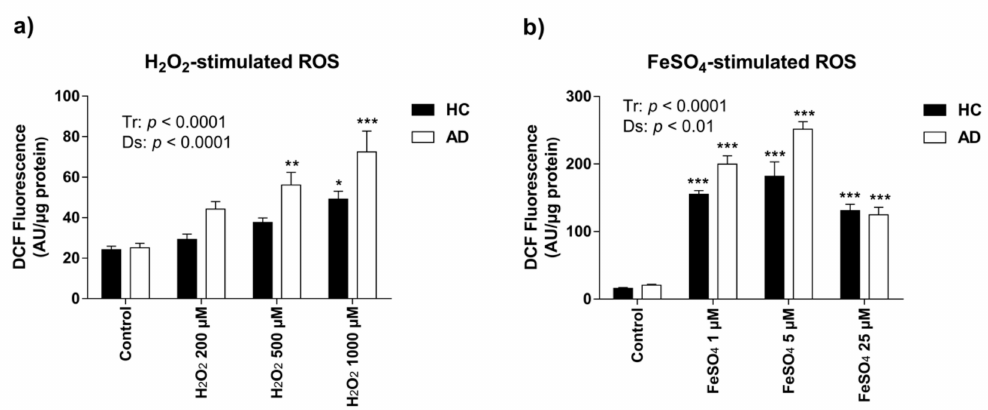
Figure 1. Reactive oxygen species (ROS) generation by lymphoblast cell lines in response to acute exposure (1 h) to oxidizing agents measured by 2 (cid:48) 7 (cid:48) -dichloro-dihydro-fluorescein diacetate (DCFH-DA) assay. ( a ) H 2 O 2 –stimulated ROS. One h of treatment with H 2 O 2 induced oxidative stress, showing significant greater ROS generation in Alzheimer’s disease (AD) than in healthy control (HC) lymphoblasts. Two-way ANOVA indicated an e ff ect of both treatment (Tr) (F(3,16) = 19.52; p < 0.0001) and disease (Ds) (F(1,16) = 17.21; p < 0.001); ( b ) FeSO 4 -stimulated ROS. FeSO 4 induced oxidative stress. Two-way ANOVA indicated e ff ects of both Tr (F(3,16) = 122.2 and p < 0.0001) and Ds (F(1,16) =